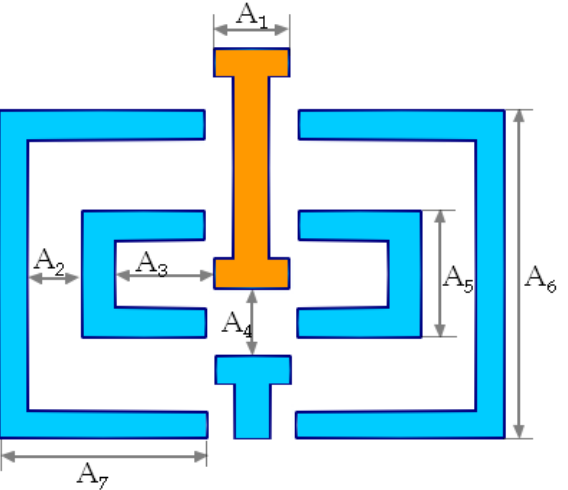
Figure 1. Geometrical denotations of eSRR unit cell including widths, gaps, and lengths. The orange column is described as the movable I-shaped metal bar.